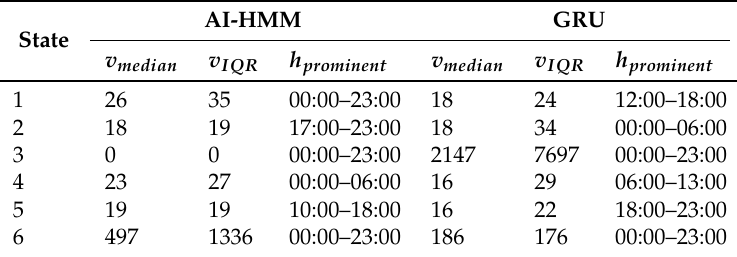
Table 1. Cluster statistics (velocity in